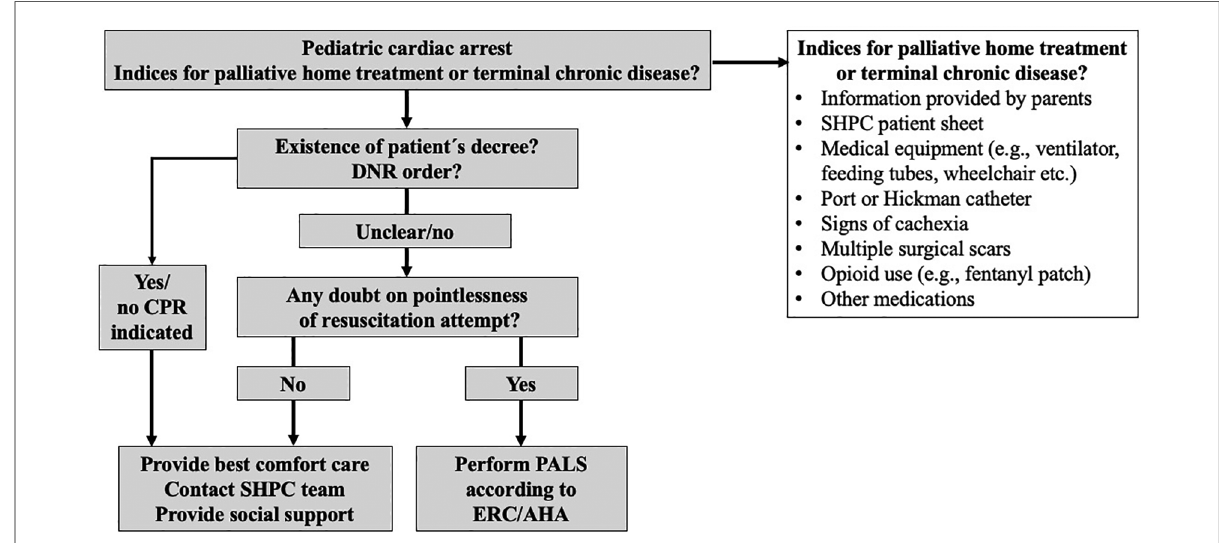
FIGURE 5 Algorithm for the management of cardiac arrest in pediatric patients under home palliative therapy. Abbreviations: AHA, American heart association; DNR, Do not resuscitate; ERC, European Resuscitation Council; PALS, Pediatric advanced life support; SHPC, Specialized palliative home